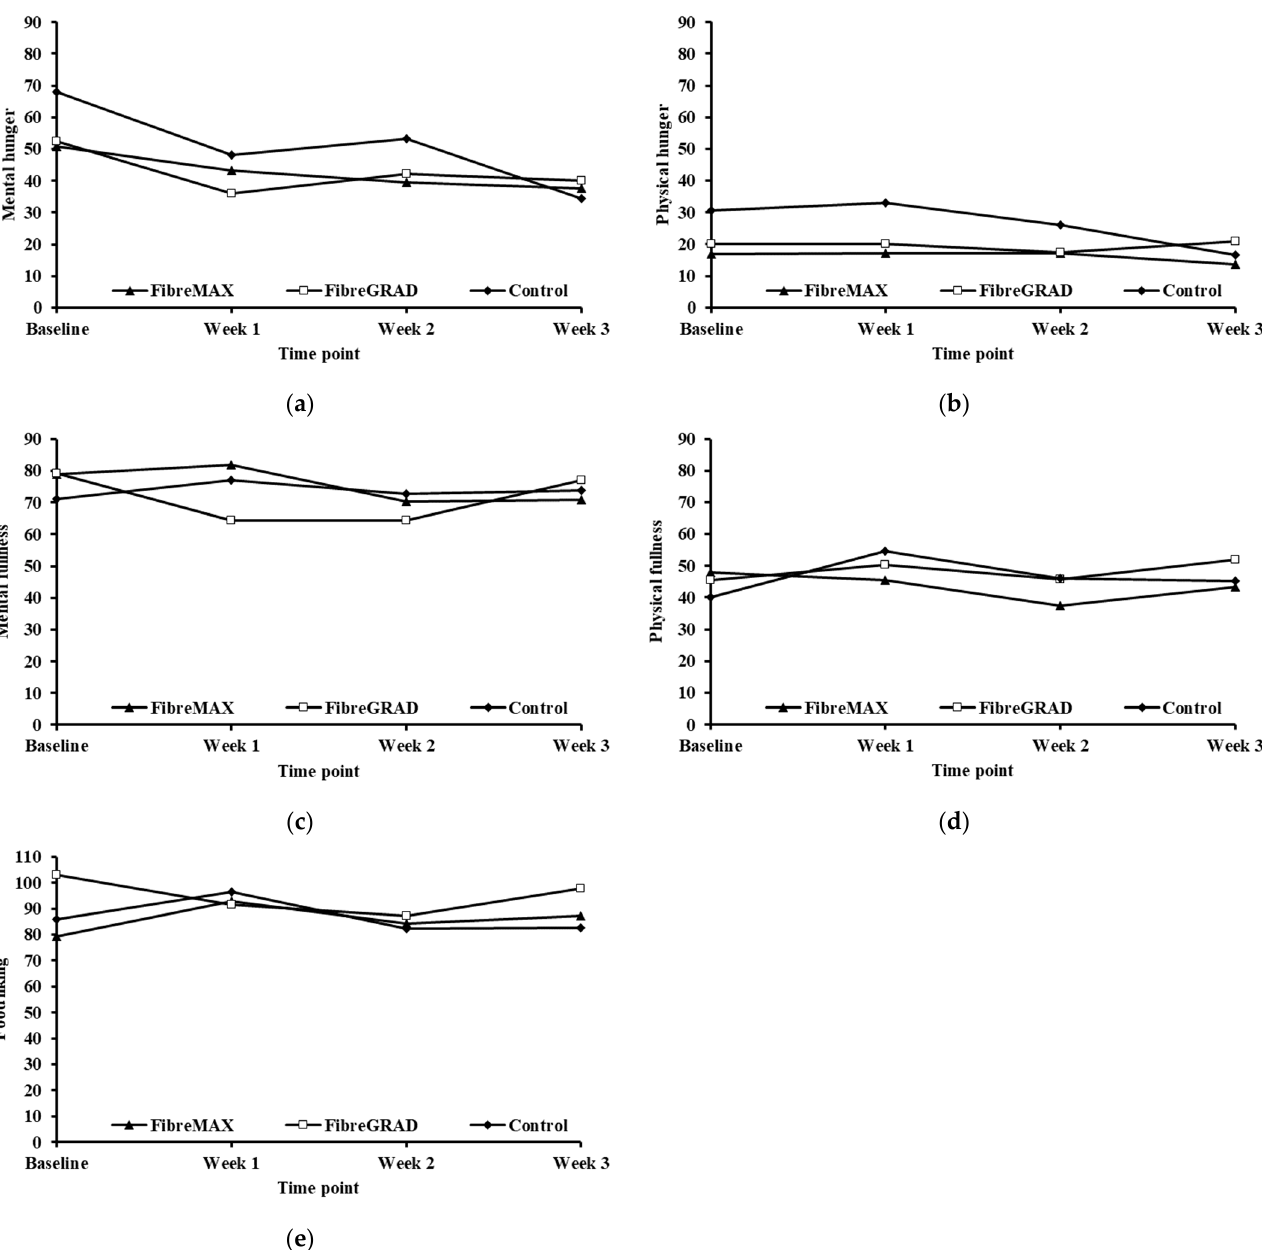
Figure A1. ( a – e ) Mean scores for the 5 satiety factors (mental hunger, physical hunger, mental fullness, physical fullness, and food liking) for the three conditions at baseline and the 3-week consumption period.